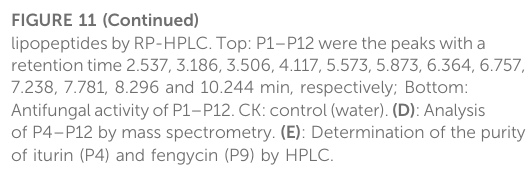
FIGURE 11 Fermentation, puri fi cation and identi fi cation of antifungal lipopeptides. ( A) : Fermentation of antifungal lipopeptides in bioreactor. (B) : Separation of antifungal lipopeptides by silica gel column. Left: The extracted substances in n -butanol were separated by silica gel column; Right: Antifungal activity of crude lipopeptides separated by silica column. (C) : Purifying antifungal